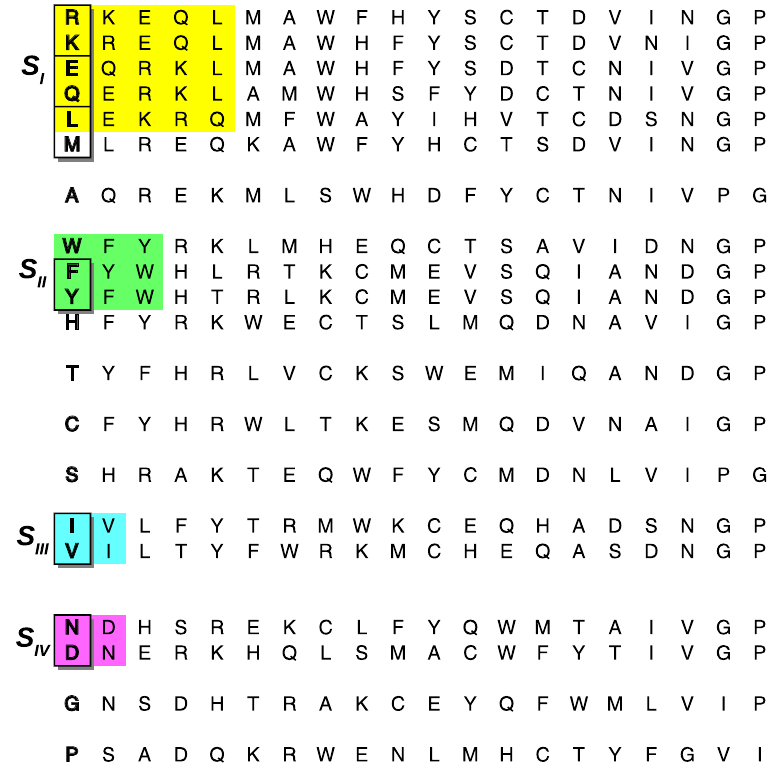
Figure 3. Rows ordered according to the cityblock distance. Open sets are indicated by the same color code used in Fig. 1. The shadowed boxes contain the BLOSUM100 pair replacements. The procedure for determining an open set consists on finding rows with the same set of first neighbors. For instance, the first neighbor of Arg (top row) is Lys; after placing the Lys row under the top row, we see that they share the seven first neighbors (up to Trp). The third row corresponds to Arg second neighbor, i.e. Glu, which also shares the same first neighbors with the previous ones up to Trp. The fourth row corresponds to Arg third neighbor, i.e. Gln, whose fifth neighbour is Ala, unlike the previous rows. The fifth row corresponds to Arg fourth neighbor, i.e. Leu, which has all the previous rows as its first neighbors. In this way, the yellow box includes those elements whose first four neighbors are completely contained within the set. Methionine is a frontier element of this set: its first five neighbors are exactly the elements of the whole closed set; however, Glu does not include Met within its first five neighbours and for that reason Met is not contained in the set. The remaining open sets S II to S IV were obtained in the same way. Notice that Pro and Gly are the farthest residues from any other one, as a consequence of their structural propensity